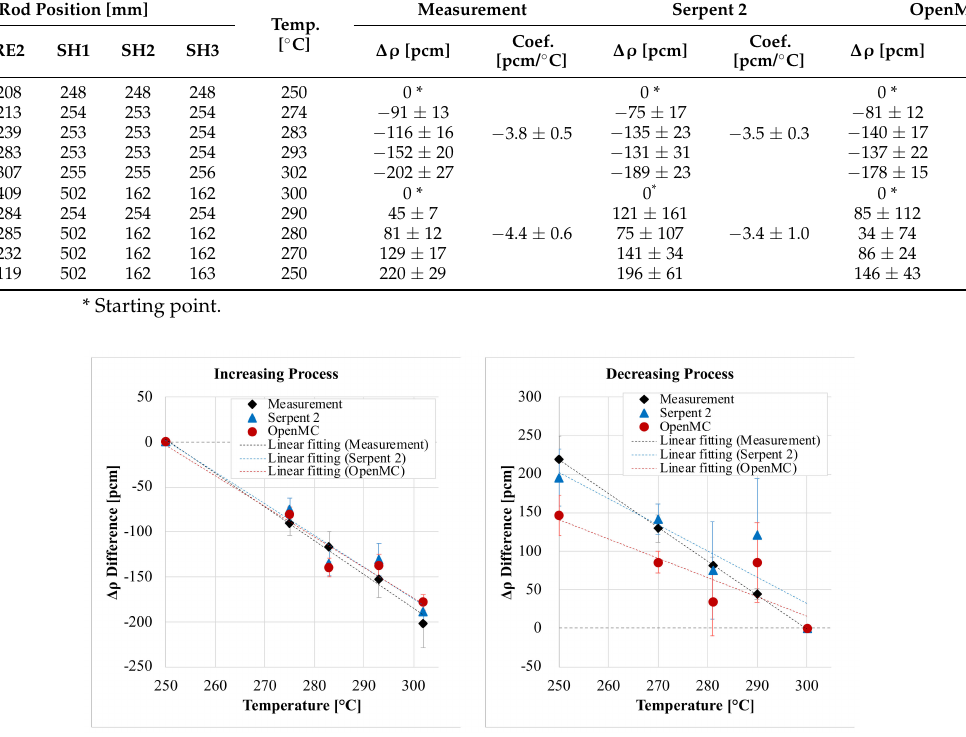
Figure 13. Reactivity change as function of temperature: increasing process and decreasing